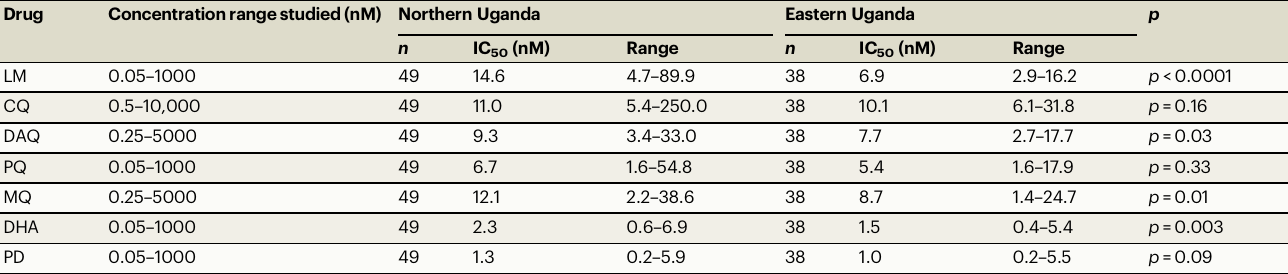
Table 3 | Drug susceptibilities of P. falciparum isolates from northern and eastern Uganda Drug